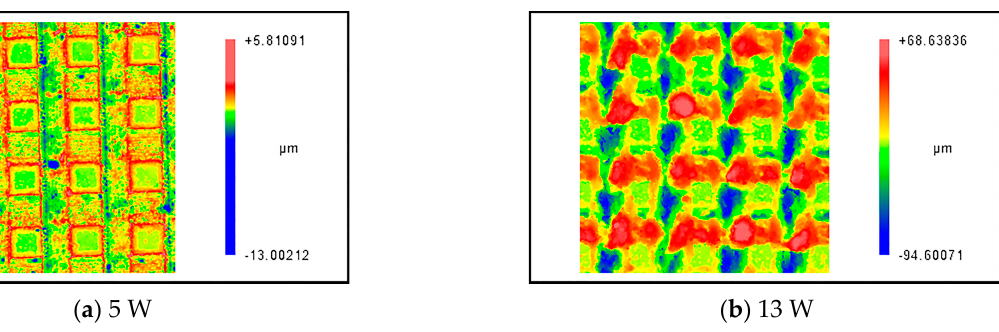
Figure 13. Experimental results of laser processing at di ff erent average powers (Pulse width = 40 ns, frequency = 150 kHz, scanning speed = 100 mm/s).